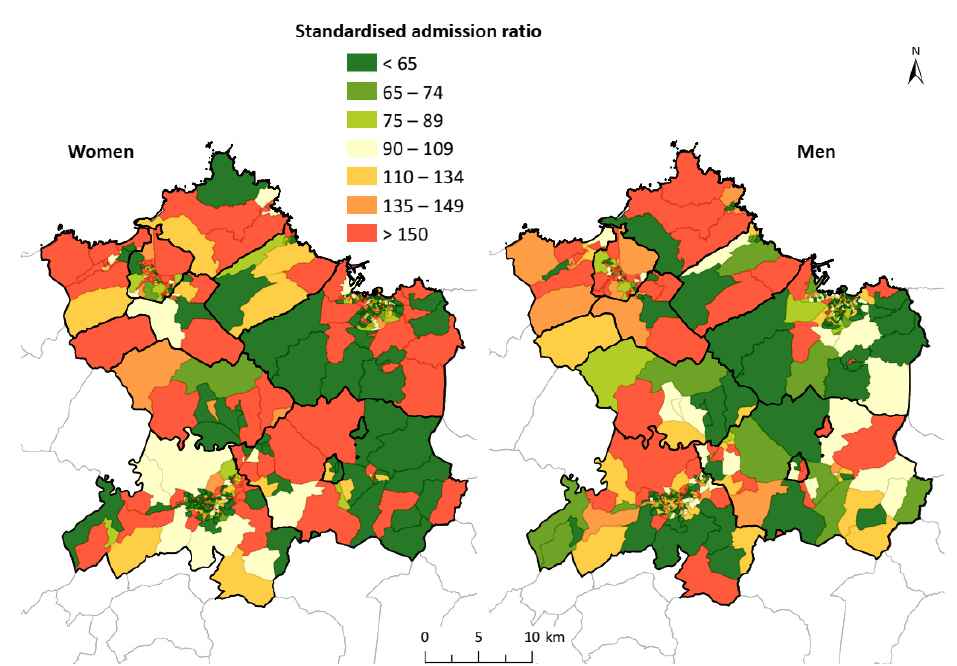
Figure 2. Standardized admission ratio for AMI and AP in the study area. The geographical distri- bution of the standardized admission ratio shows a dispersed distribution of high values for both men and women, without a clear pattern in the distribution.